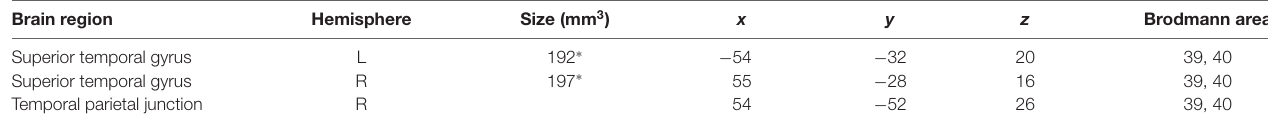
TABLE 3 | Results from bodily self-consciousness (BSC) experimental study ( N = 22) FDR-corrected, p < 0.05 and neurological patients study ( N = 9) based on voxel-based lesion symptom mapping (VLSM) FDR-corrected, p < 0.01. Brain